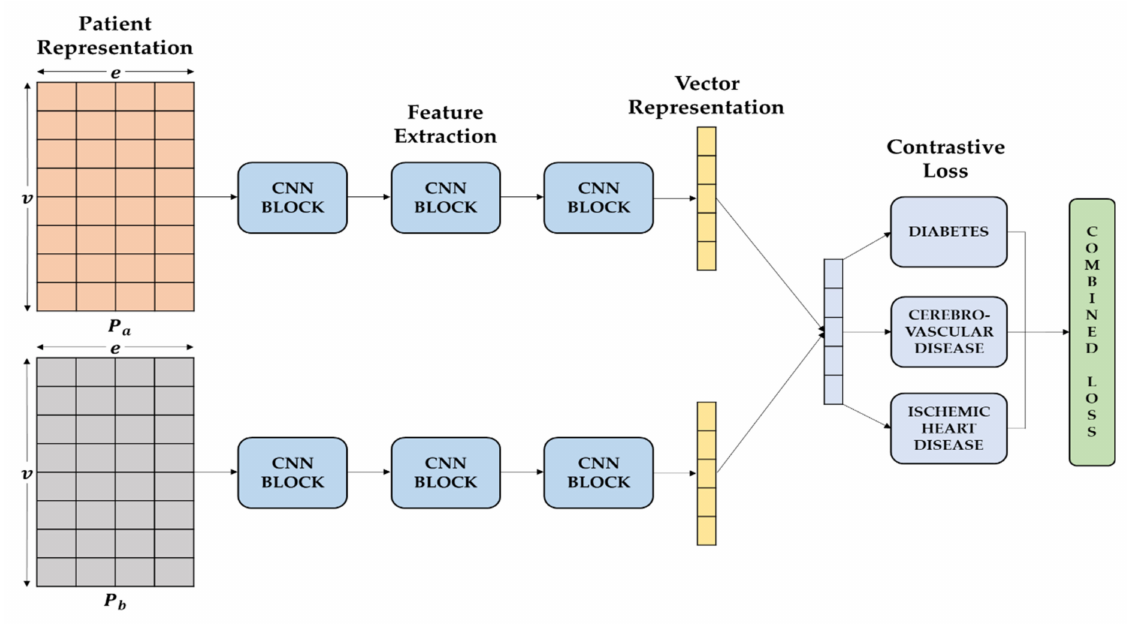
Figure 4. An illustration of proposed similarity learning.